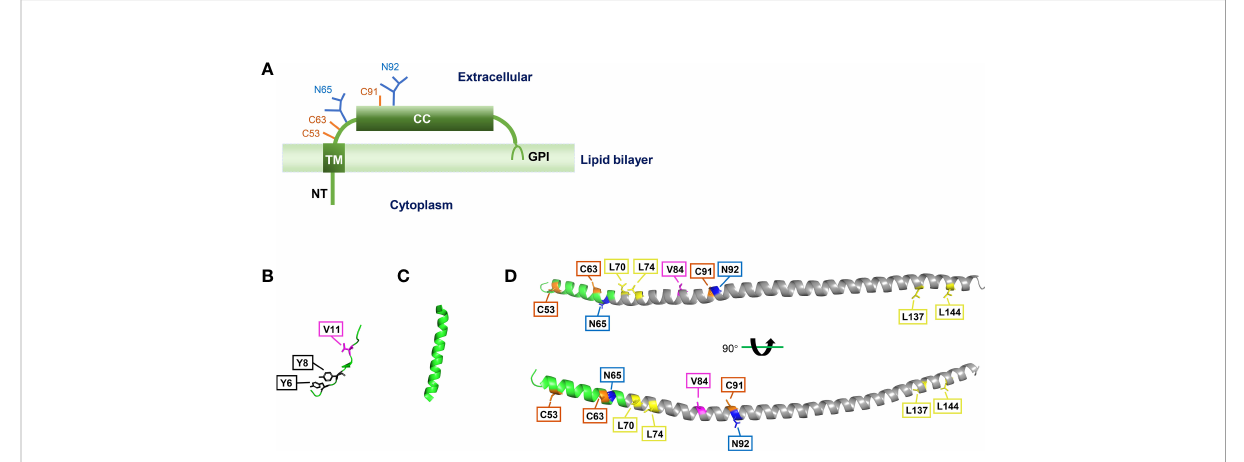
FIGURE 1 Structure of BST2. (A) Main features of BST2 structure. NT, N-terminal cytoplasmic tail; TM, transmembrane region; CC, extracellular coiled-coil domain; GPI, glycosyl-phosphatidylinositol anchor. (B) Crystal structure of BST2 NT domain, separated from crystal structure of the human BST2 cytoplasmic domain and the HIV-1 Vpu cytoplasmic domain bound to the clathrin adaptor protein complex 1 (AP1) core (Jia et al., 2014) (RCSB PDB code: 4P6Z). (C) Crystal structure of BST2 TM domain (Skasko et al., 2012) (RCSB PDB code: 2LK9). (D) Crystal structure of BST2 ectodomain (Schubert et al., 2010) (RCSB PDB code: 3NWH). The CC domain is labeled in gray. These structures were re-constructed with the PyMOL software (version 2.5.3). Speci fi c amino acid residues are highlighted as follows: tyrosine residues = black boxes; valine residues = pink boxes; disul fi de bonds = orange boxes; N-linked glycosylation sites = blue boxes; leucine residues = yellow